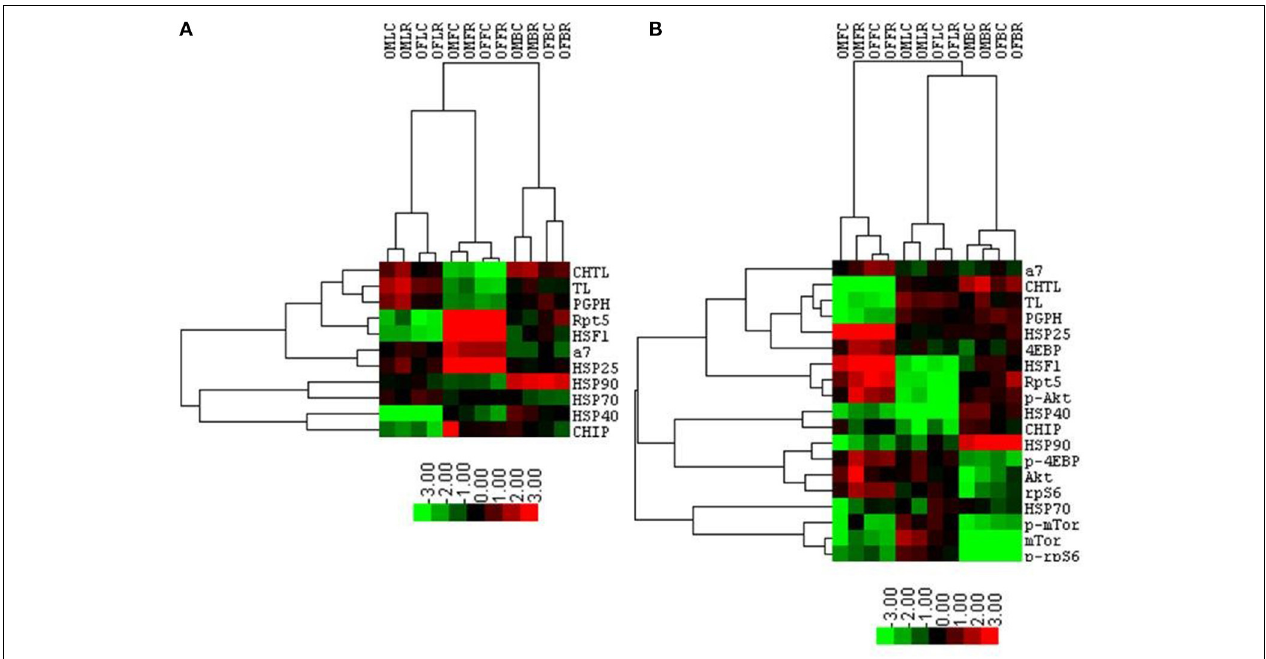
FIGURE 11 | Cluster analysis shows a proteasome-influenced grouping by tissue, sex, and then treatment. A heat map showing results of the cluster analysis of variables including log-transformed peptidolytic activities and quantities of proteins determined by immuno-blot first with proteasome activity, proteasome subunits, and several proteasome-related chaperones together (A) , and then with the addition selected mTOR pathway proteins (B) . Groups representing the various lysates collected from animals treated with rapamycin and corresponding controls are organized in columns represent cases. Four letter codes define the groups with the first two in the code representing gender